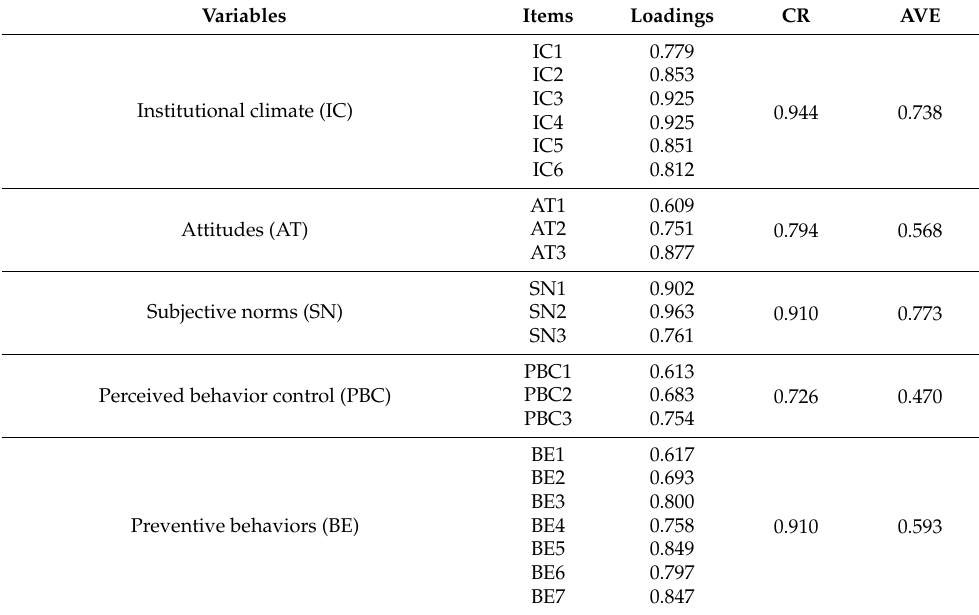
Table 3. Standard factor loading of items and reliability of the